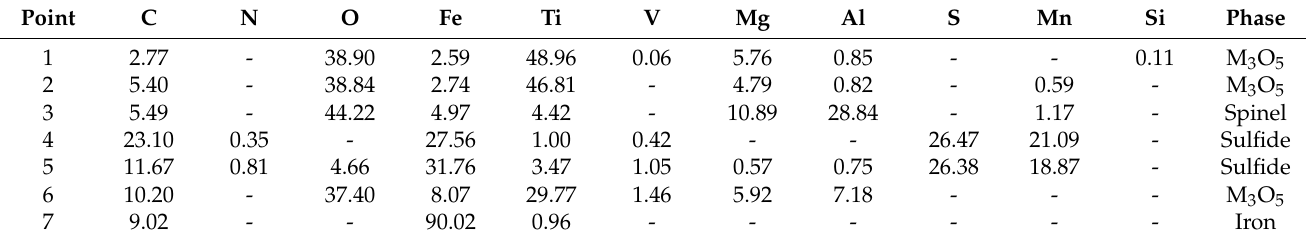
Table 4. Elemental composition of points shown in Figure 5